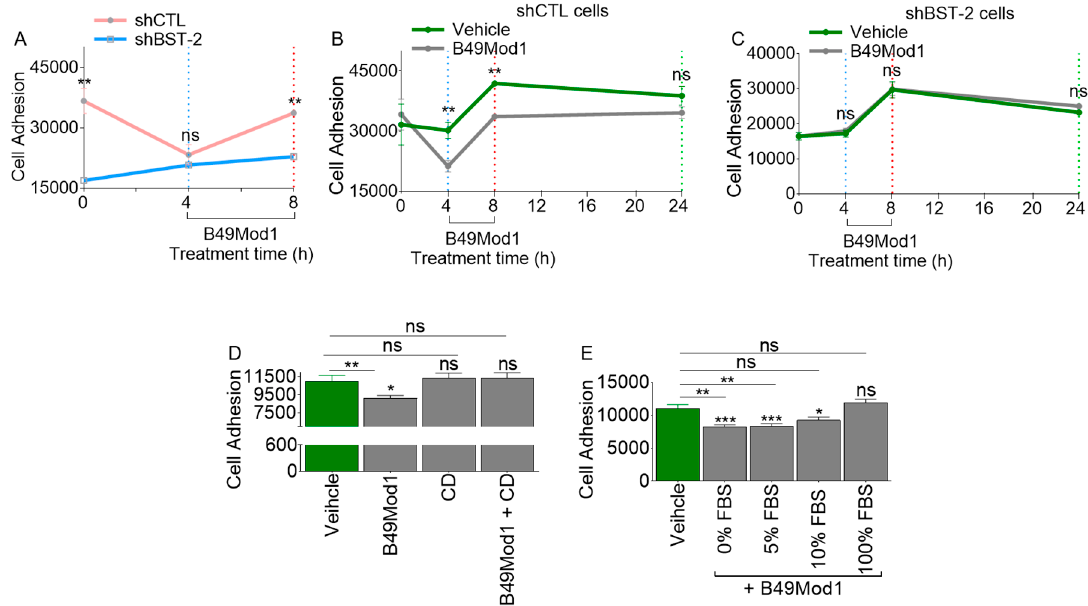
Figure 3. B49Mod1 loses potency upon extended incubation times. ( A ) Adhesion of PKH67 Green-labeled shCTL and shBST-2 4T1 cells onto B49Mod1-treated 4T1 shCTL monolayers at 0, 4, and 8 hours. ( B ) Adhesion of PKH67 Green-labeled shCTL 4T1 cells onto Vehicle or B49Mod1-treated